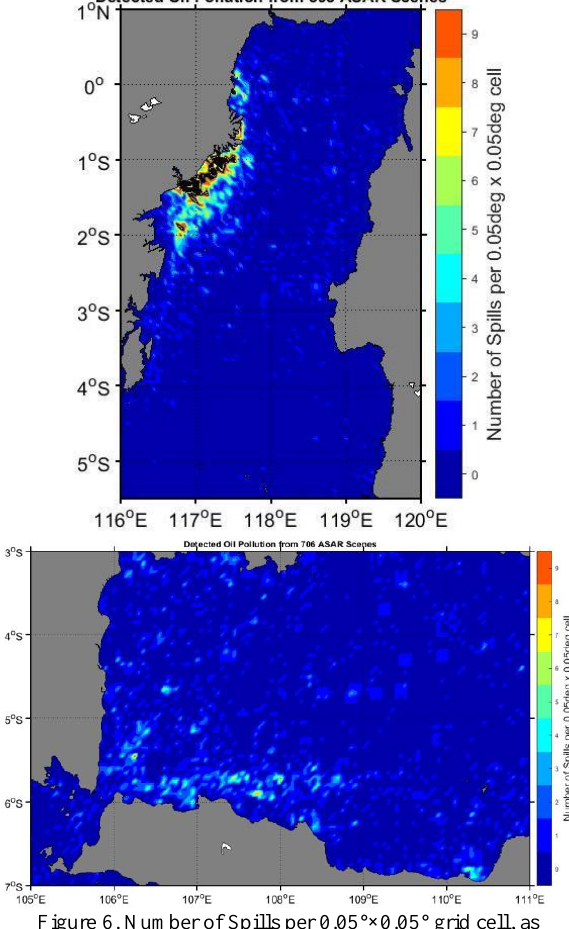
Figure 6. Number of Spills per 0.05°×0.05° grid cell, as detected in more than 1600 ENVISAT ASAR images of both ROI.